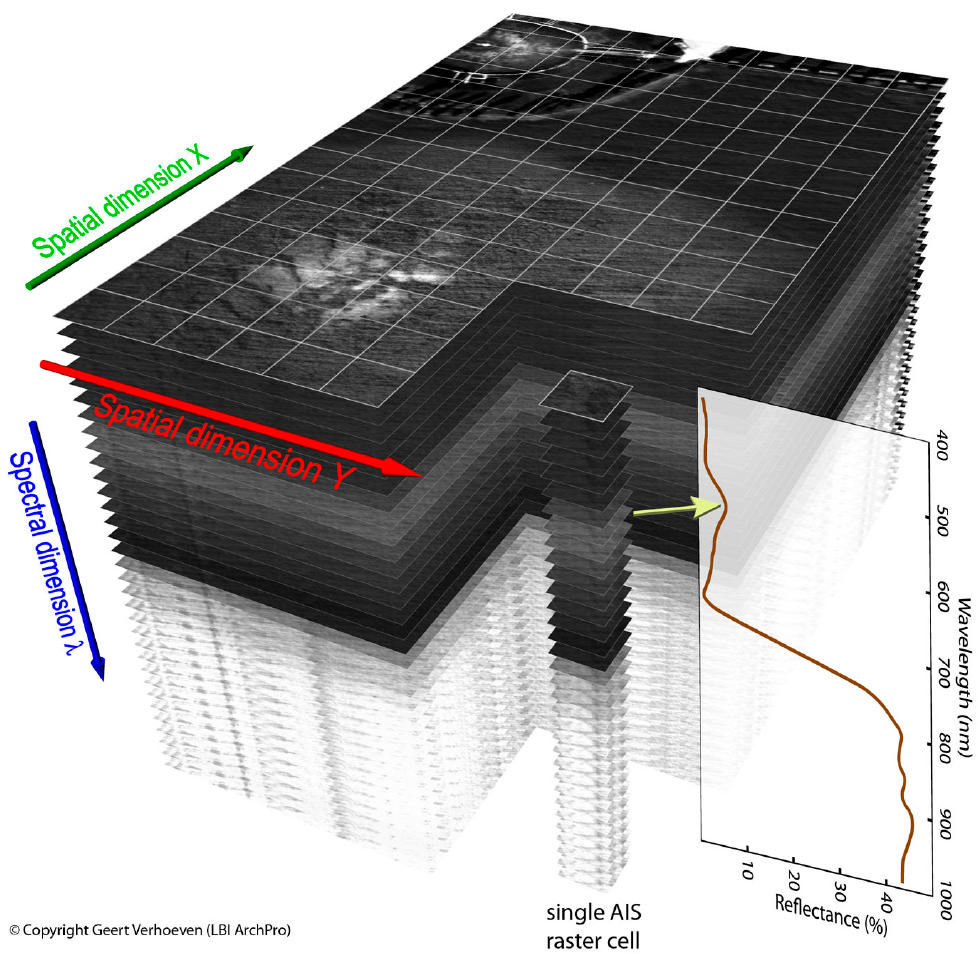
Figure 7. Visualisation of an airborne imaging spectroscopy data cube.